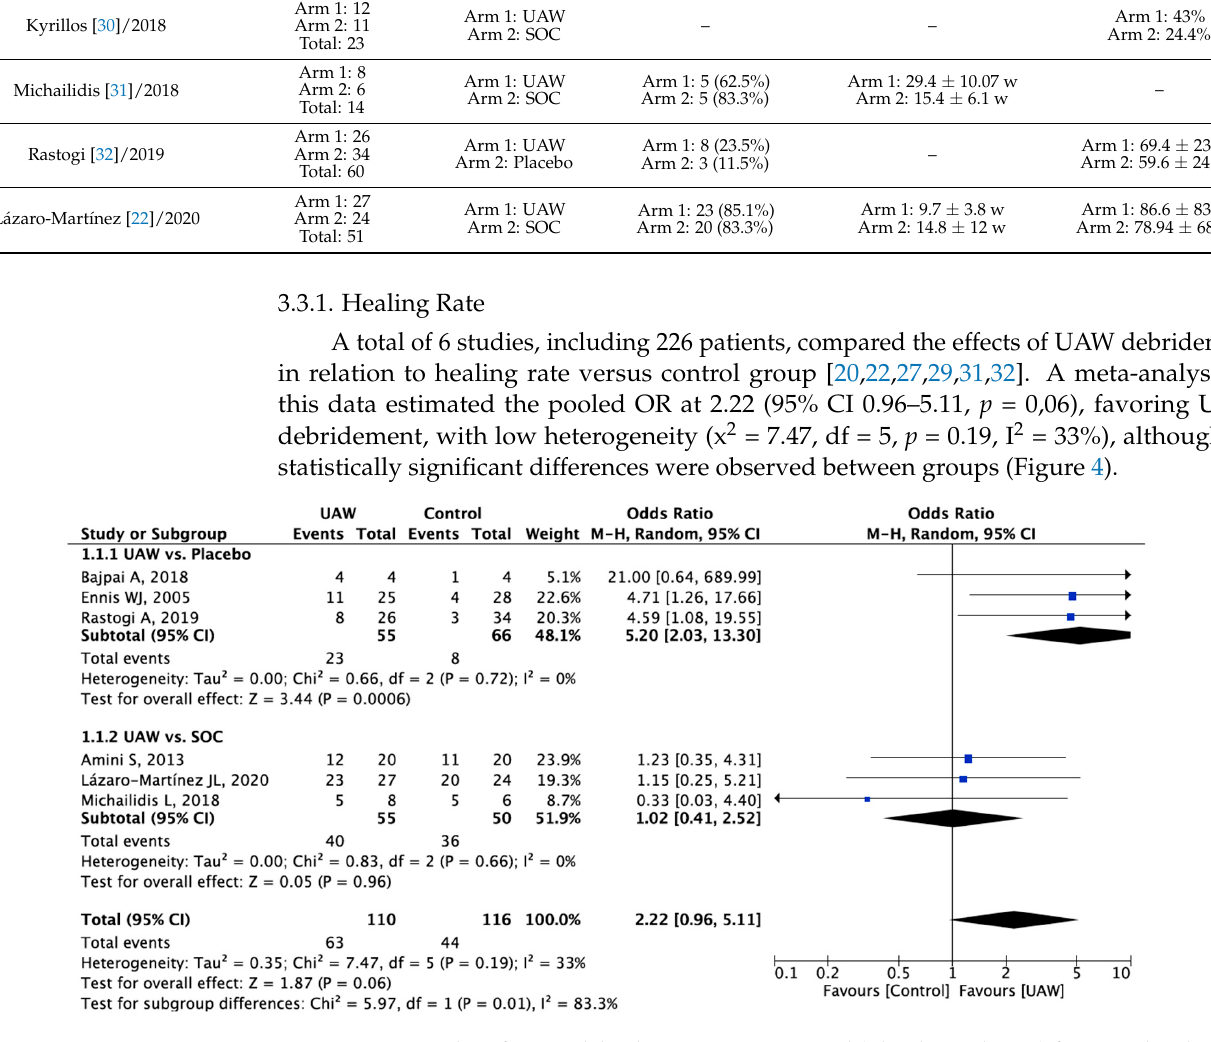
Figure 4. Forest plot of UAW debridement versus control (placebo and SOC) for complete healing rate. Bold text means overall outcomes per subgroups. Blue square: Odd Ratio for each study (measure of effect of each study).